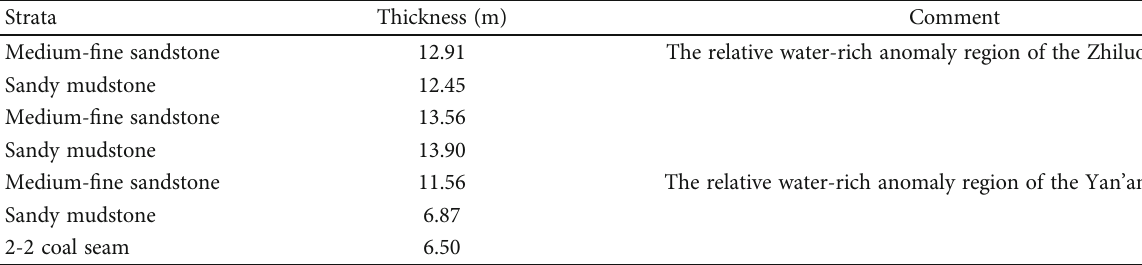
Figure 8: Spatial relationship of the roadway (the blue line is 2202 auxiliary transport roadway). Table 1: Composite columnar section of the 2202 working